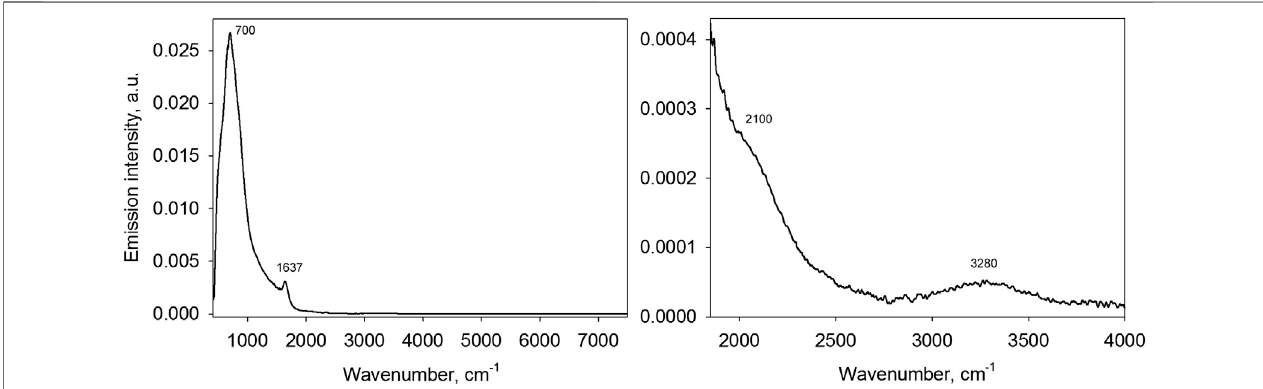
FIGURE 5 | A water emission spectrum at 25 ° S in the range of 400 – 7,500 cm − 1 (on the left) and the same spectrum scaled up (on the right) .